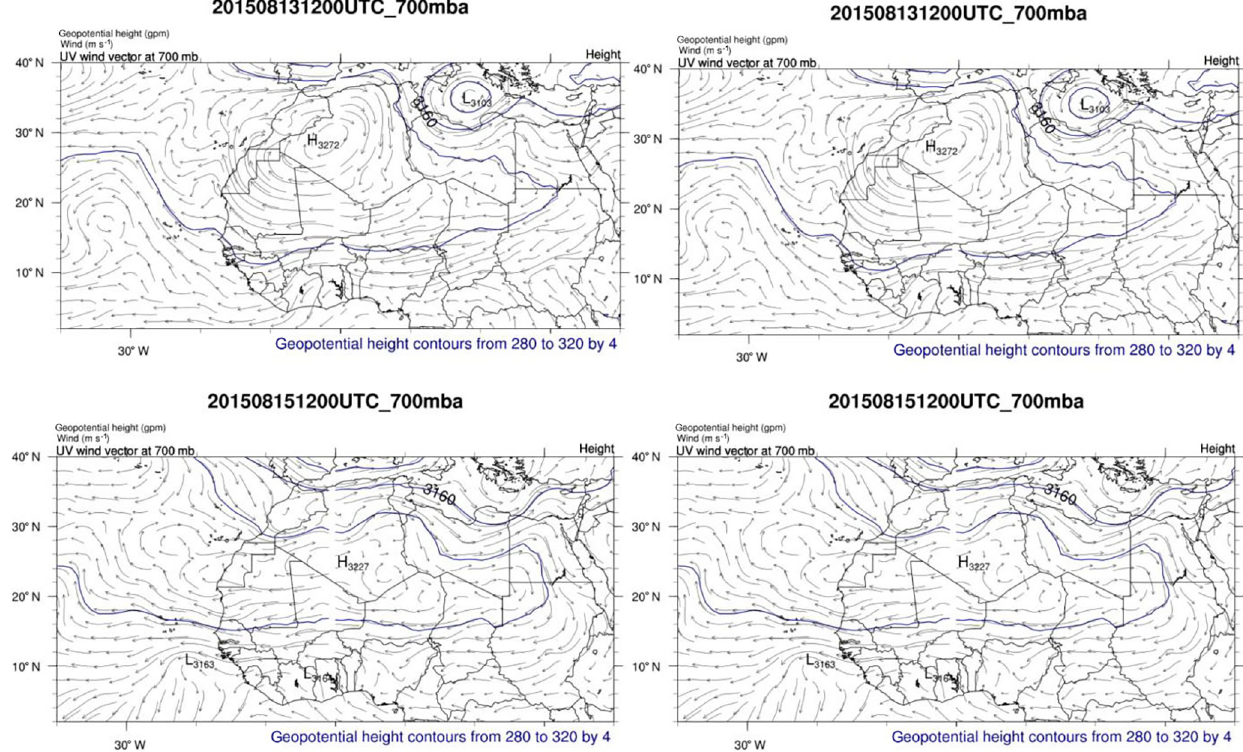
Figure 4. The 700hPa geopotential height and wind field from 13 to 16 August based on ECMWF